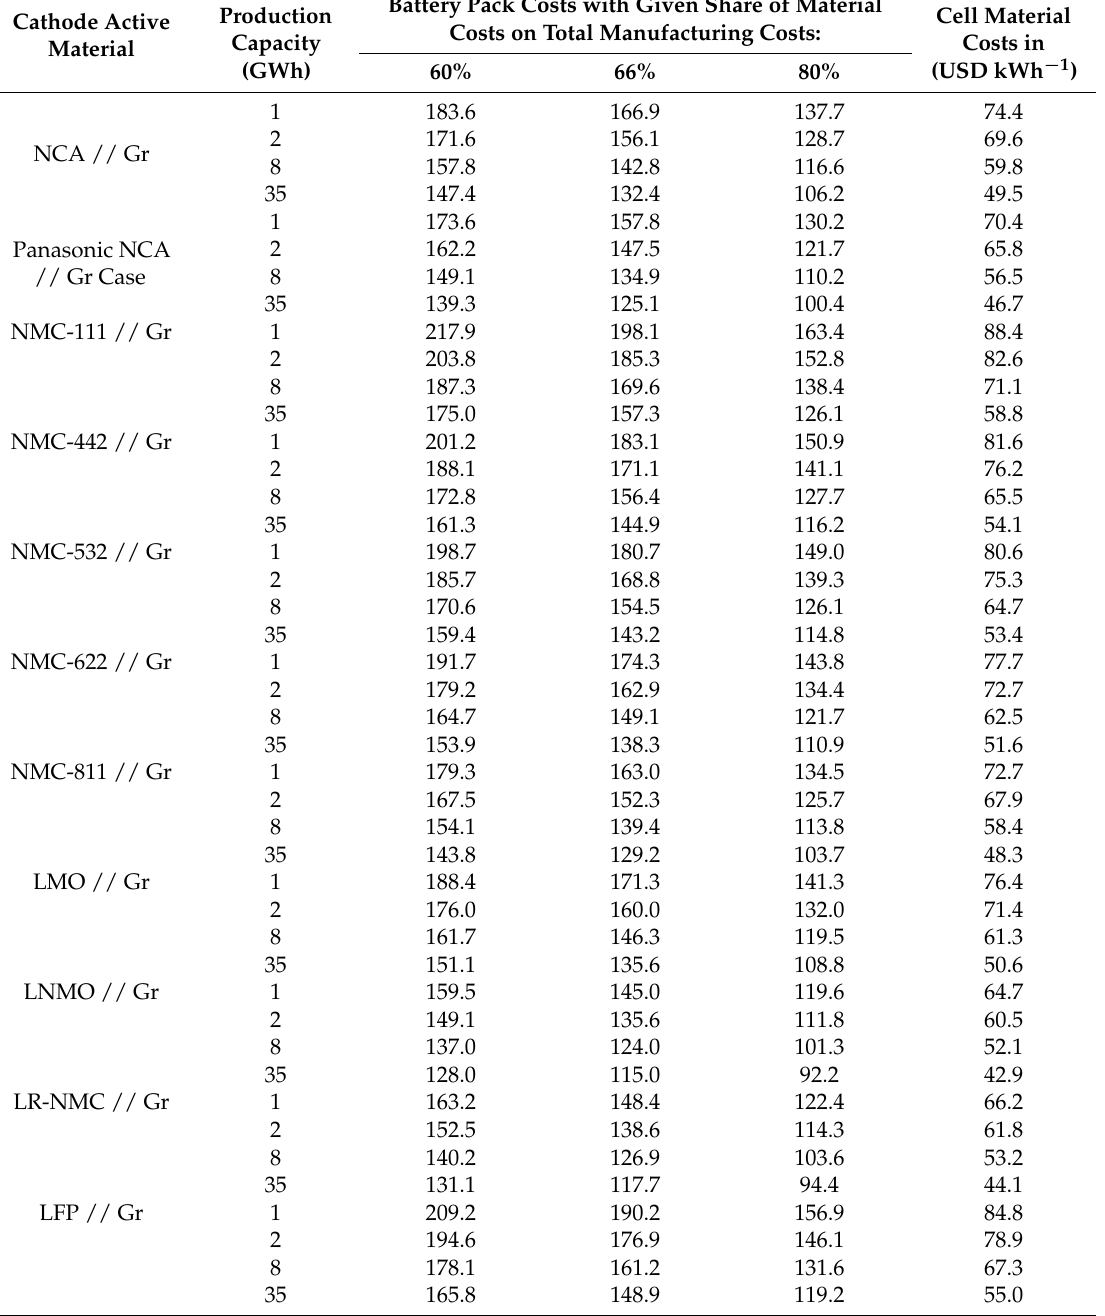
Table 4. Cost of Battery Pack, estimated by cost-plus pricing, without any overhead and capital investment. Cathode